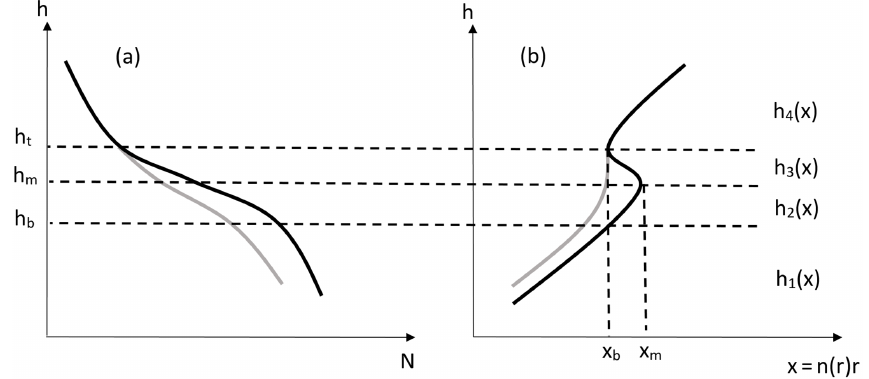
Figure 1. The illustration of the corresponding refractivity profile (a) and the h(x) function (b) when ducting occurs. The true profiles are shown in black and the profiles acquired by GNSS-RO Abel retrievals are shown in grey. The large refractivity gradient between h m and h t causes the negative slope of h 3 (x) and the multivalued function h(x) between x b and x m . √ √ x b − x/ x m − x b . By using Eq. (9), all the possible z =